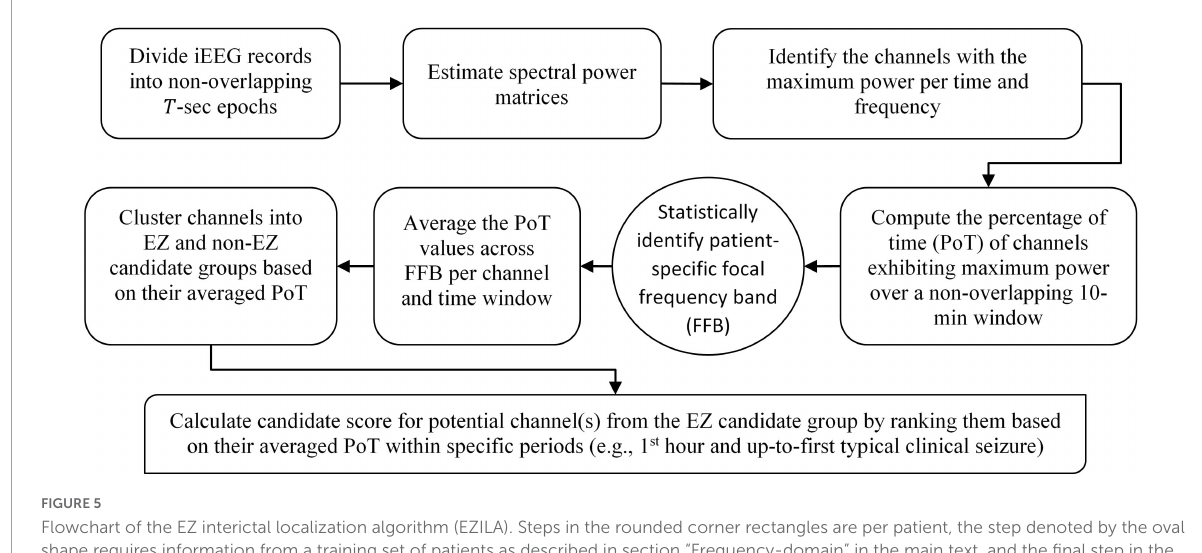
FIGURE5 Flowchart of the EZ interictal localization algorithm (EZILA). Steps in the rounded corner rectangles are per patient, the step denoted by the oval shape requires information from a training set of patients as described in section “Frequency-domain” in the main text, and the final step in the diagonal rounded rectangle represents the main output of the algorithm per